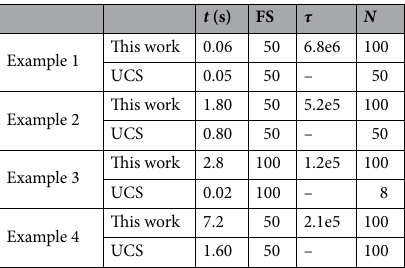
Table 1. Comparison of the important parameters of all studied